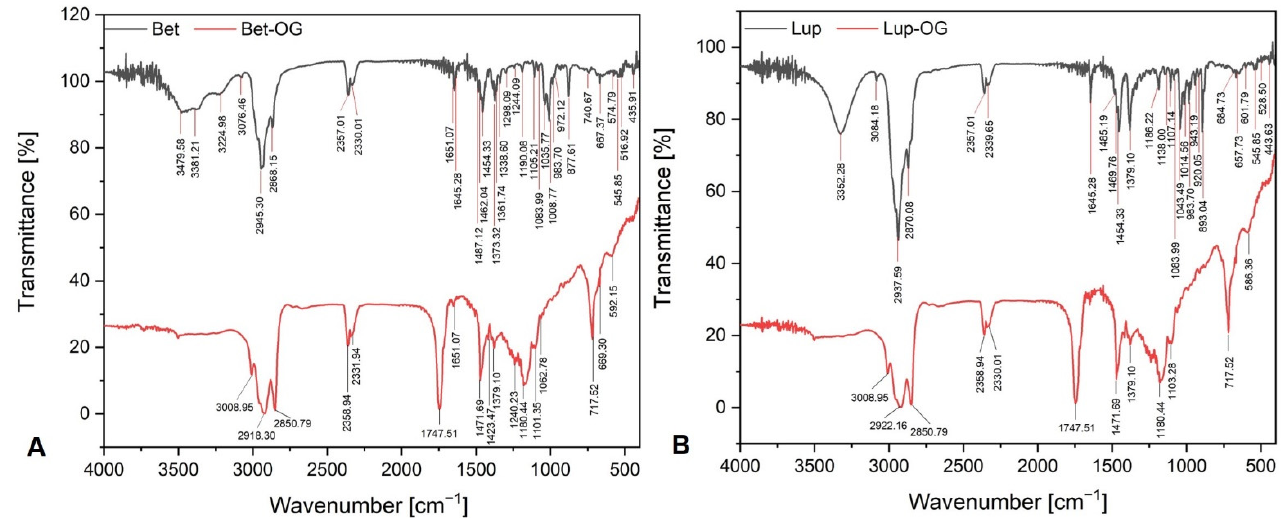
Figure 3. FT-IR spectra of Bet OG ( A -red line) and Lup OG ( B -red line) alongside with FT-IR spectra of pure botulin ( A -black line) and lupeol ( B -black line).